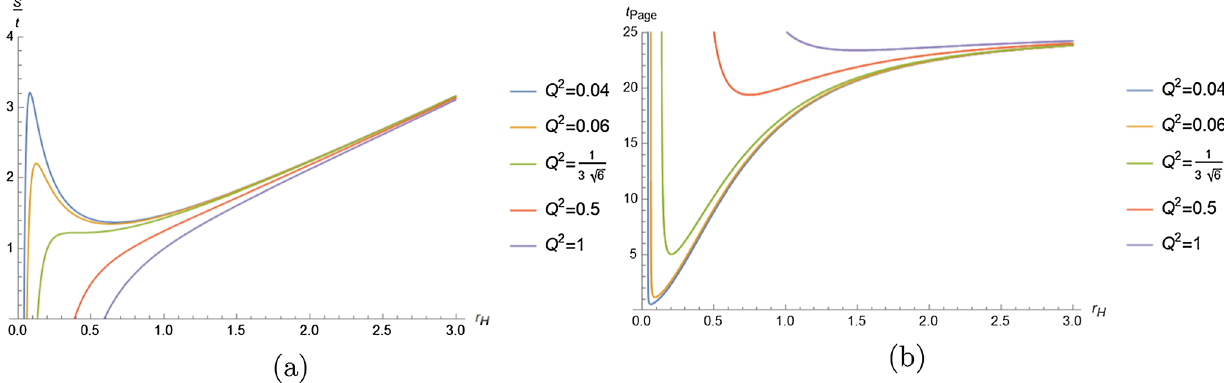
Fig. 7 The increased rate of the entanglement entropy and the Page time as a function for the radius at Q 2 = 0 . 04 , 0 . 06 , 1